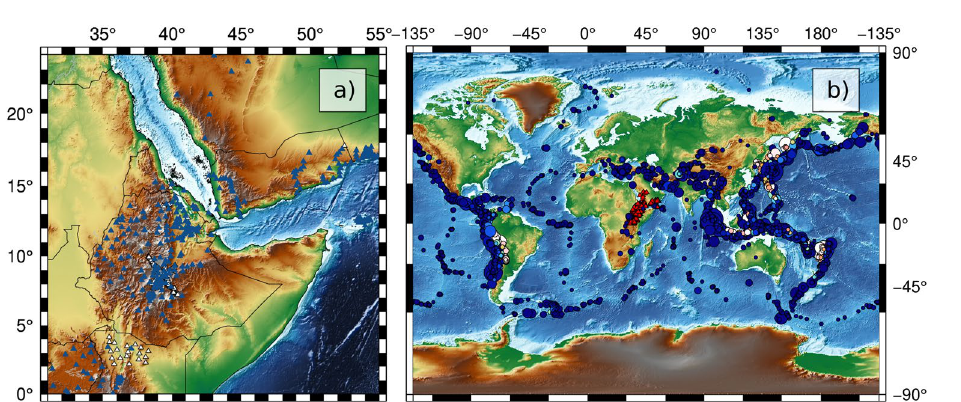
Figure 2. Map of the 361 available seismic stations ( a ) and 4,137 selected regional and teleseismic earthquakes ( b ). Individual figure panels were generated with the Generic Mapping Tool (6.3.0) 51 and PyGMT (0.7.0) 52 . Individual figure panels were combined using Inkscape (1.2.1) 53